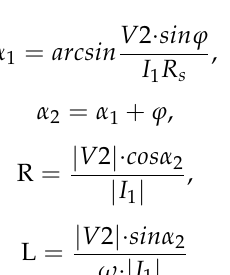
Figure 13. Equivalent measurement circuit of measure coil parameters ( L, R ).